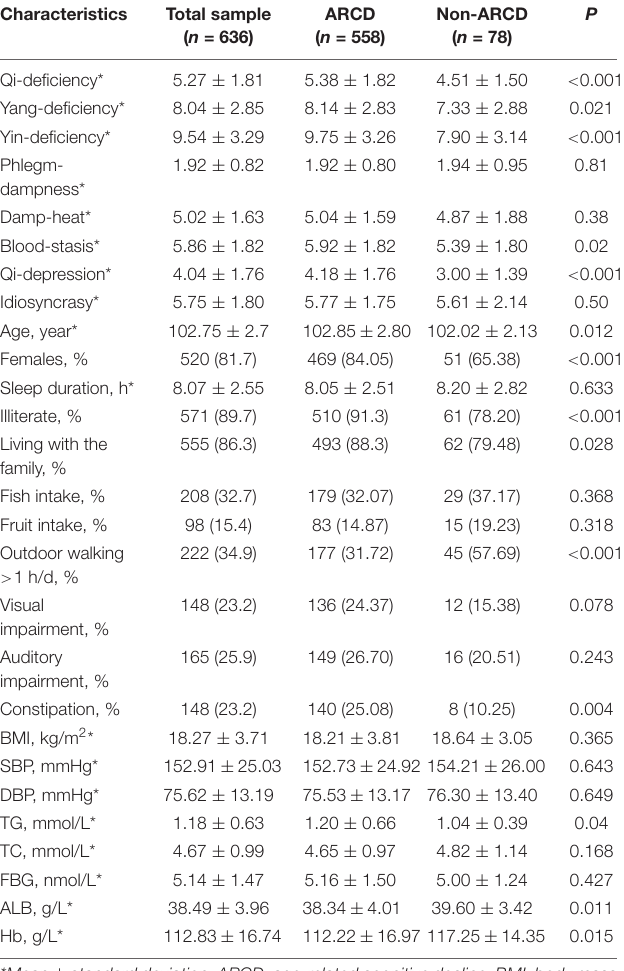
TABLE 1 | Characteristics of all participants with and without age-related cognitive decline (ARCD).